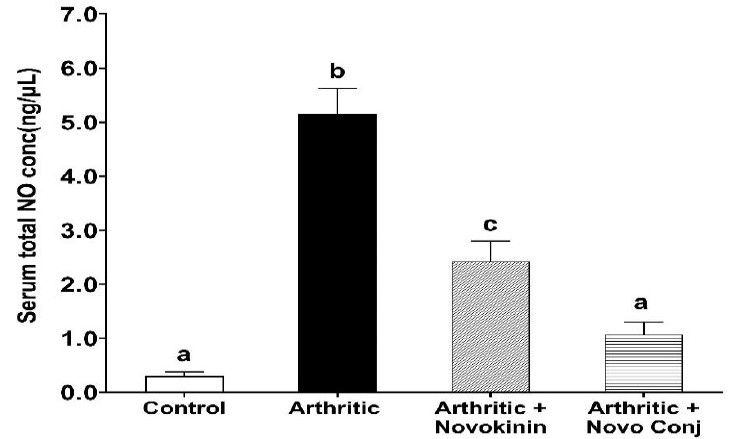
Figure 4. Treatment with novokinin conjugate (Novo Conj) reduced arthritis (AIA) induced elevated serum level of nitric oxide (NO). Mean ± SD ( n =5 or 6 rats per group). Data labeled with different letters (a, b, or c) indicate a statistical difference between groups where p < 0.05.